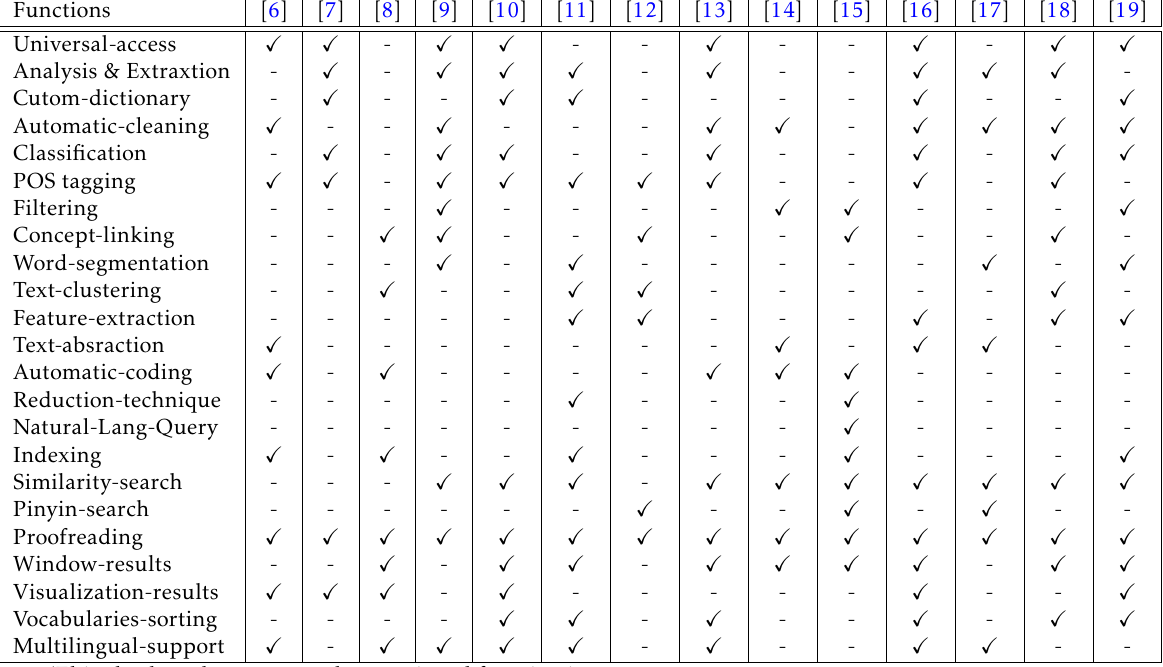
Table 2. Comparative Analysis of Different Text-mining models based on Data analysis, preperation and report functions. Functions